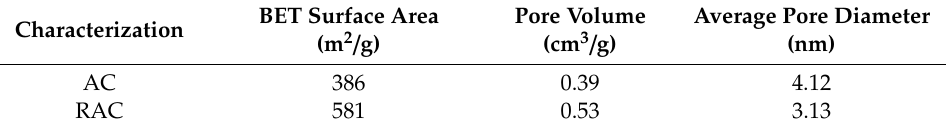
Figure 8. SEM images of the AC ( a 1 and a 2 ) and regenerated activated carbon ( b 1 and b 2 ). Table 4. Characterization of the regenerated activated carbon (RAC) and AC.